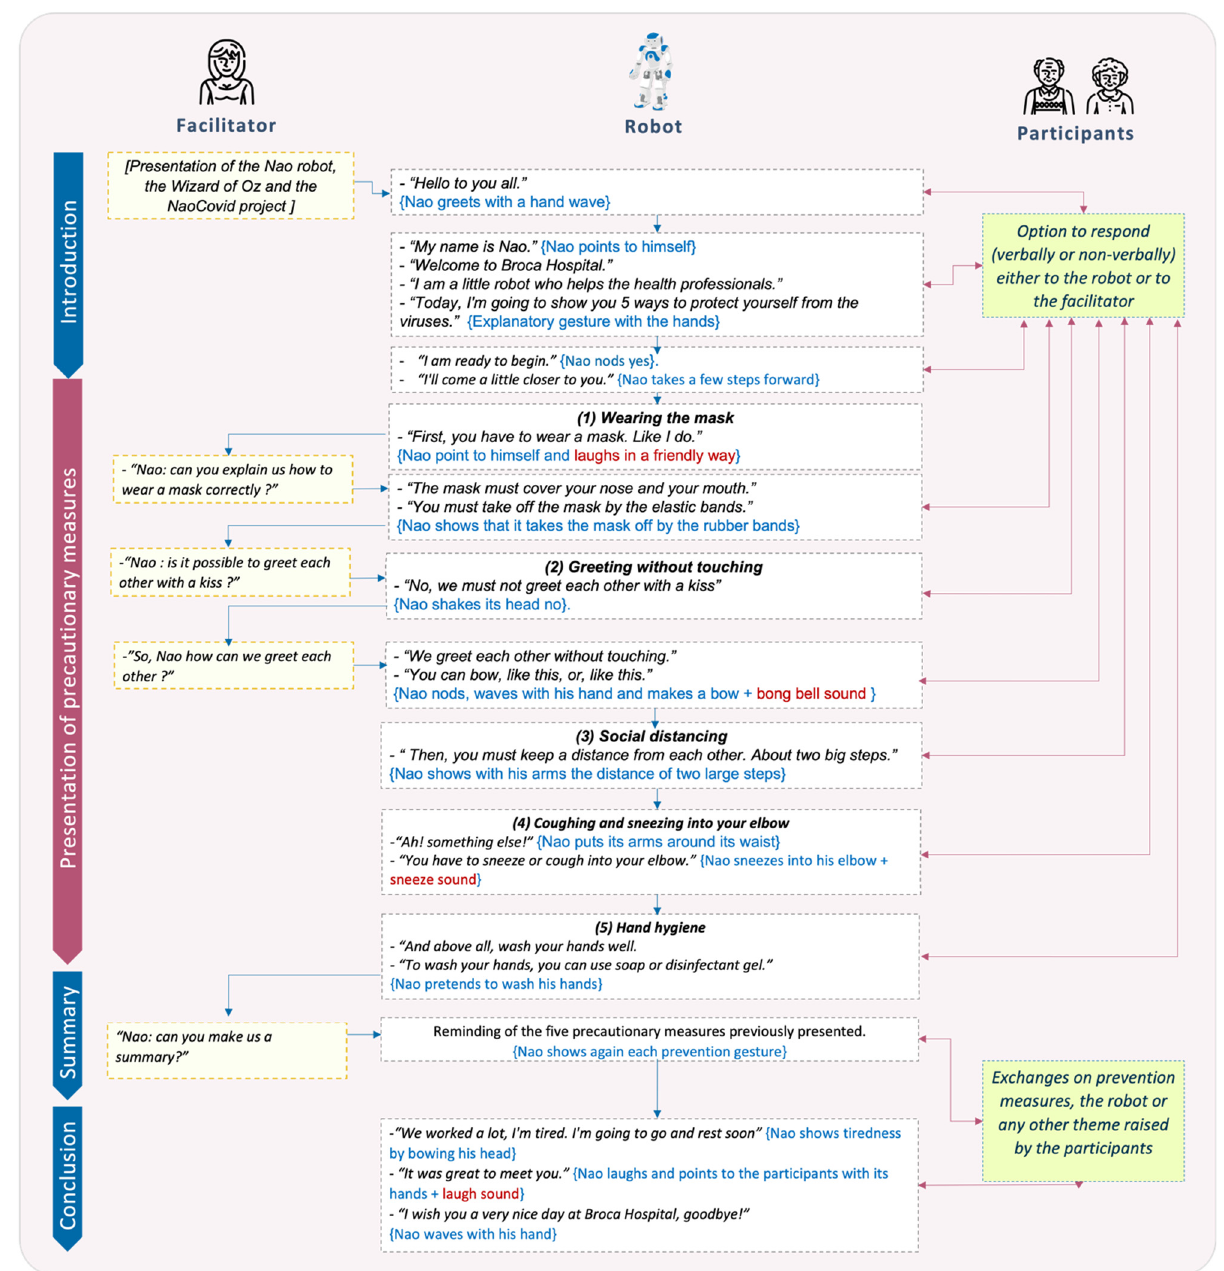
Figure 3. Outline of the interactive informational scenario for the presentation of COVID-19 precautionary measures.